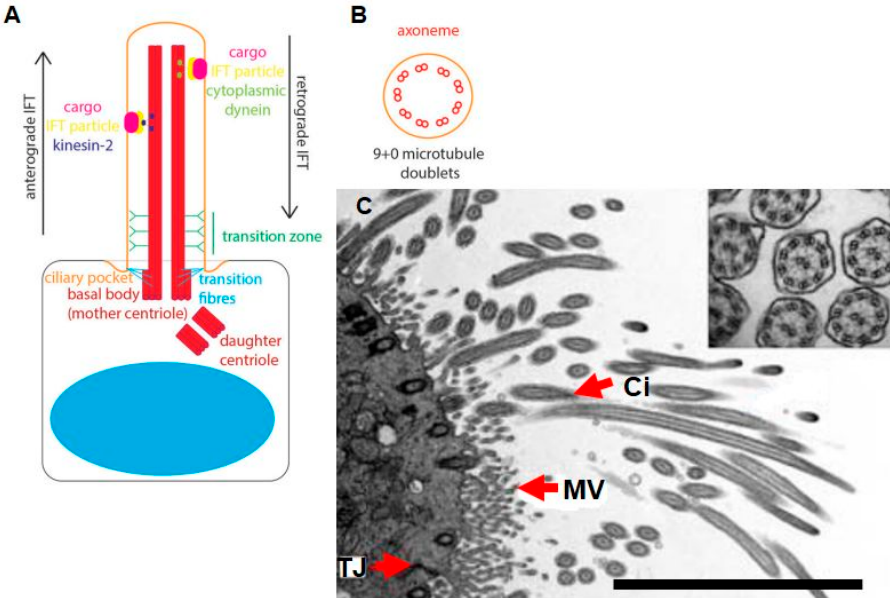
Figure 2. A schematic illustration of cytoplasmic protruding cilia, originating from the cell centrosome. ( A ) A typical primary cilium projecting from the cell surface, comprising cargo, viz., intraflagellar transport particles: kinesin-2 and cytoplasmic dyein; ( B ) a cross-section of a non-motile cilium, which assumes a 9 + 0 formation of microtubule doublets [16]; ( C ) a TEM image of tracheal epithelium and a cross-section of tracheal cilium displaying a 9 + 2 conformation. Ci denotes cilia, MV denotes microvilli and TJ denotes epithelial tight junctions. Scale bar = 8 µm [50].